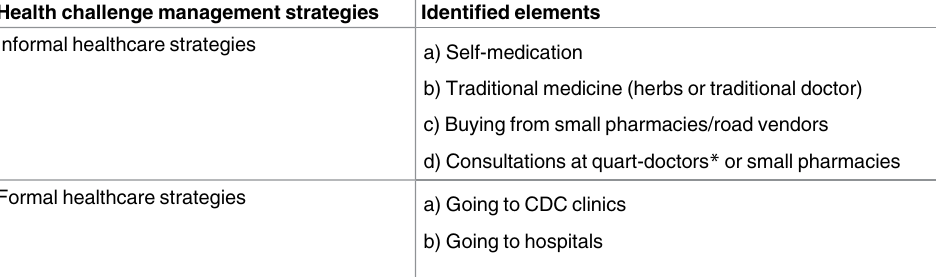
Table 2. Health management strategies and identified elements emerging from the